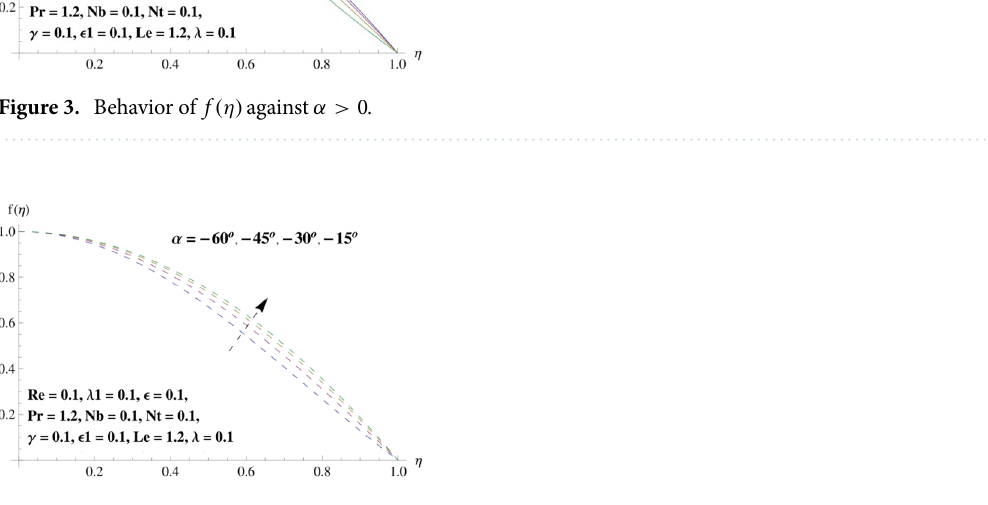
Figure 4. Behavior of f (η) against α < 0 .